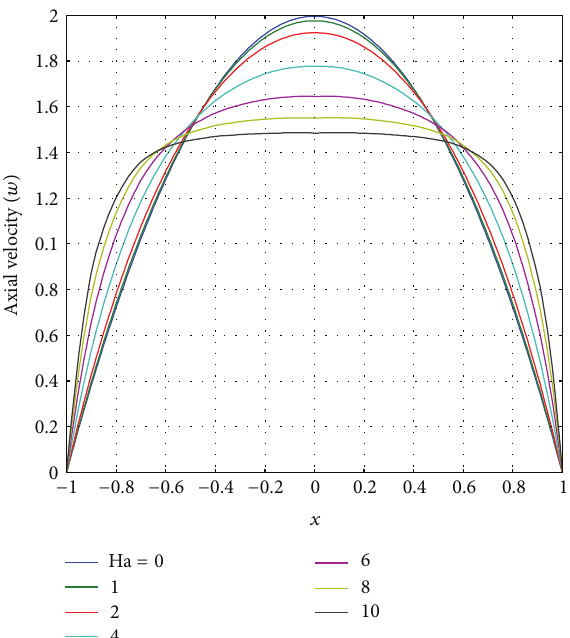
Figure 6: Axial velocity profile for different values of the Hartmann numberHa,whentheflowisfullydevelopedinsteadycasewithRe = 300 .